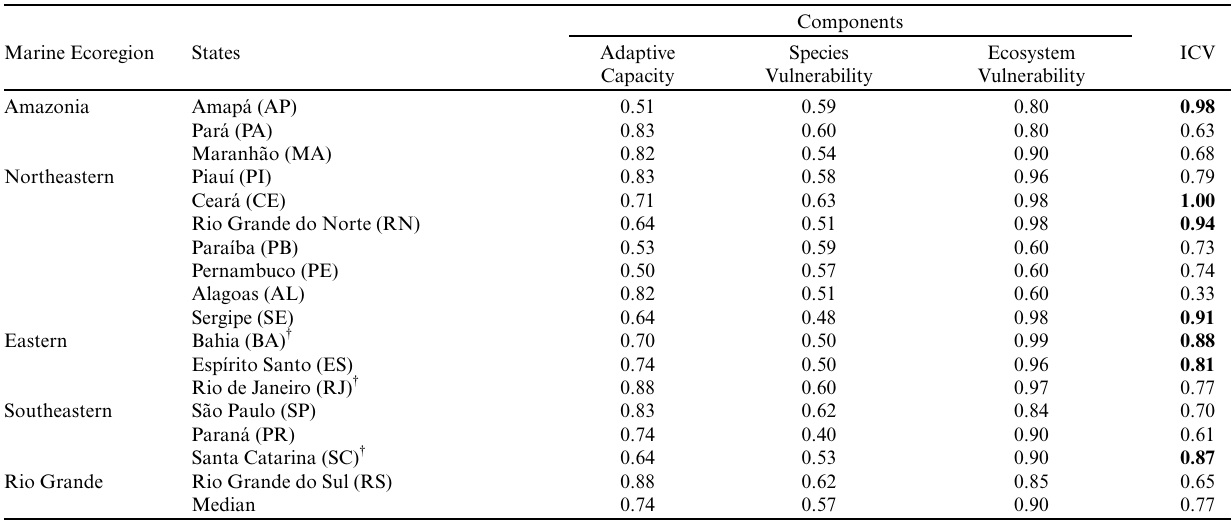
Table 3 . Scores for the 3 components and the Index of Coastal Vulnerability (ICV) in the 5 Brazilian marine ecoregions and their 17 coastal states. Both the components and the index ranged from 0 to 1. States with very high ICVs are in bold (ranges between 0.8 and 1.0).